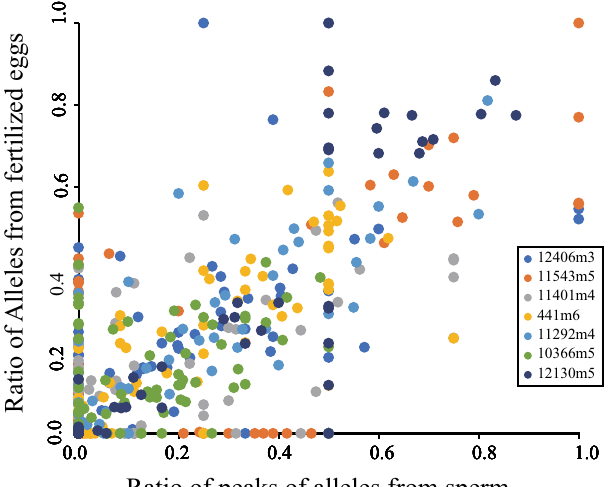
Figure 4. Relationship between alleles in the fertilized eggs and sperm in situ. Ratio of the numbers of the each MS allele (e.g., 191) and those of all MS alleles (e.g., 191 and 197) in the fertilized eggs in each seawater sample (vertical line) (e.g., Allele 191 in Float1, third collection is 2/12 = 0.167 Supplementary Information 1). The horizontal line indicates the ratio of peak heights in fragment analyses of each seawater sample (e.g., ratio of allele 191 in Float 1, third collection was = 0.16). Alleles of each MS in this study are indicated by different